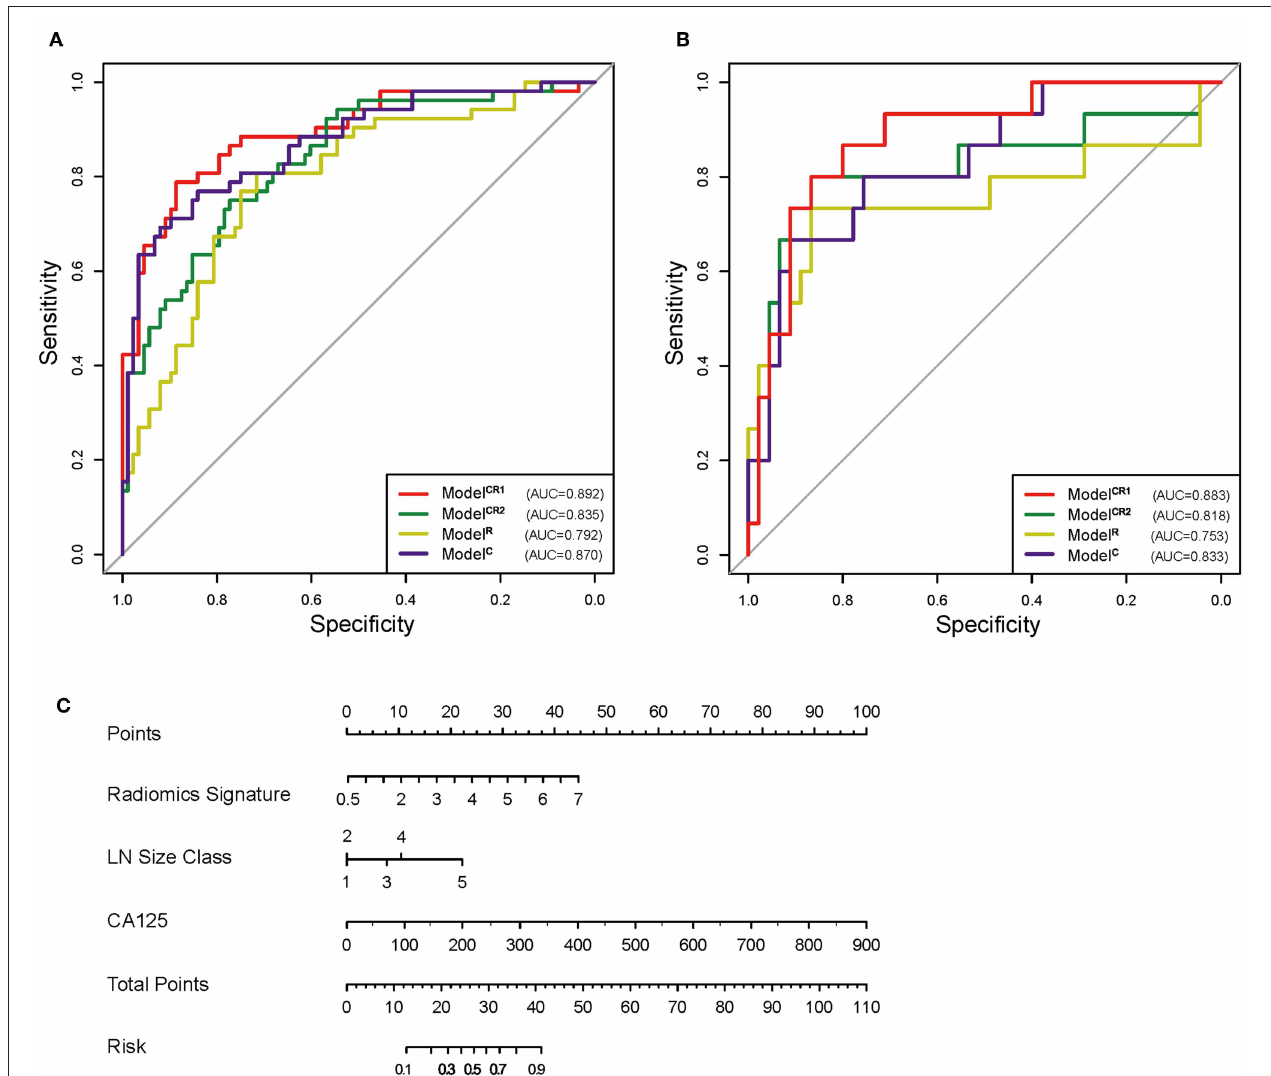
FIGURE 4 | (A) ROC of the four models in training cohort. (B) ROC of the four models in test cohort. (C) Preoperative nomogram of Model CR1 . ROC, receiver operating